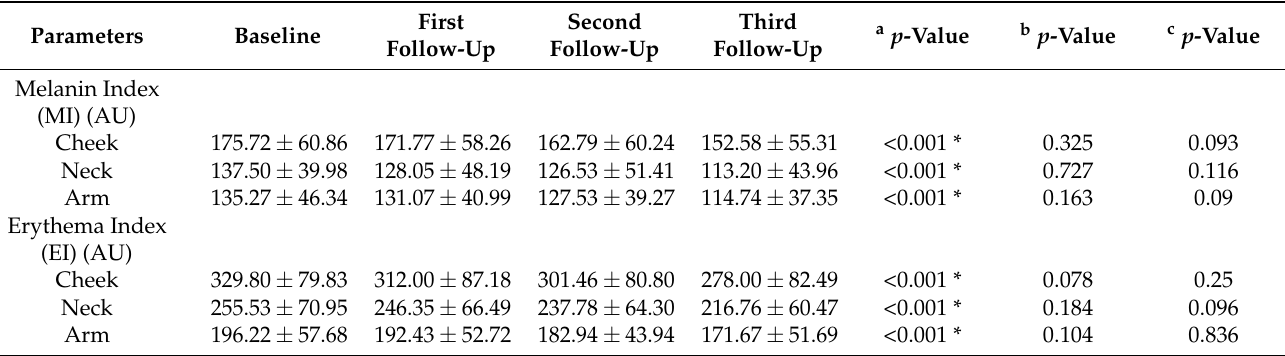
Table 4. Changes in skin pigmentation of participants during